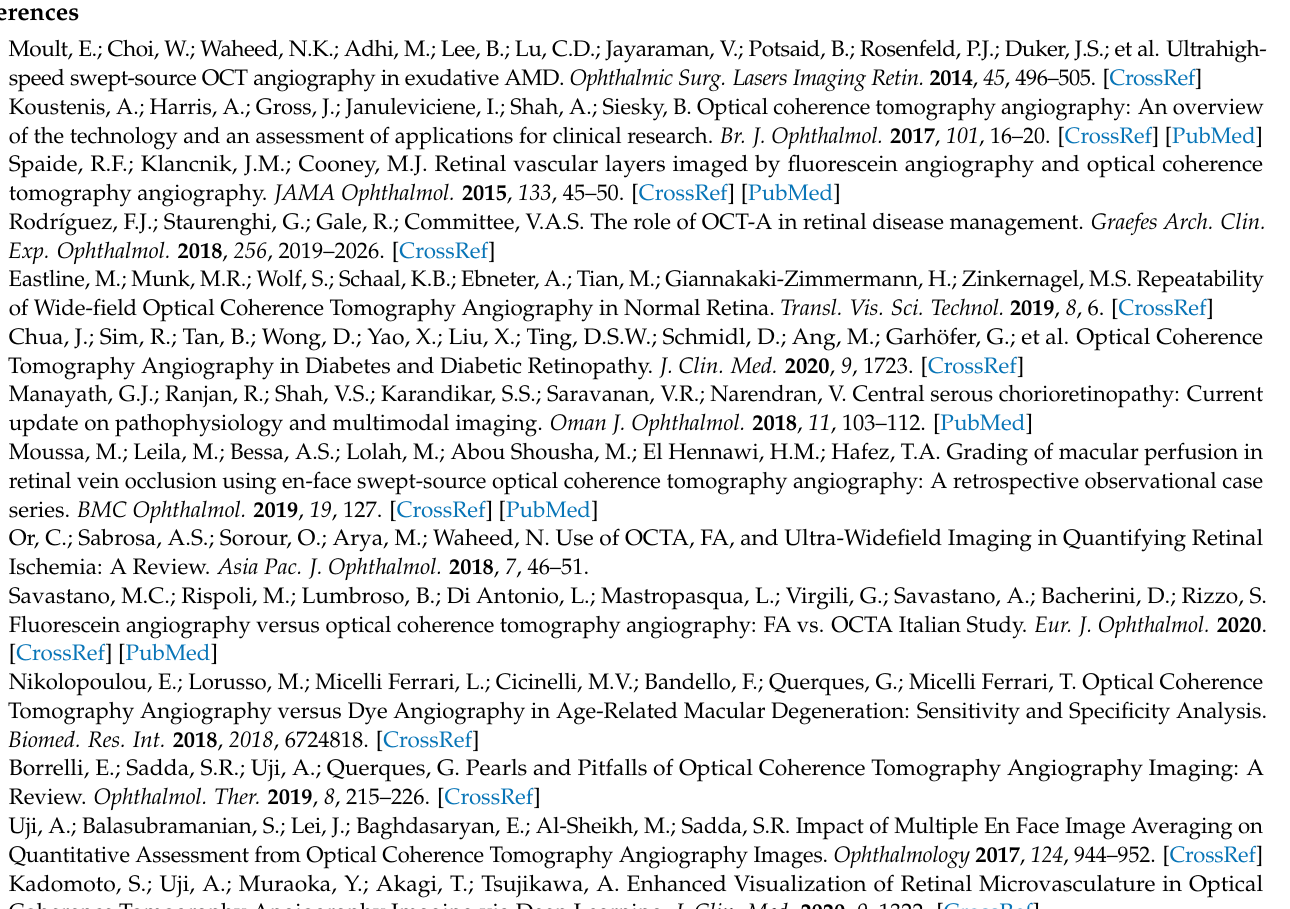
Figure A2. Proforma used by the retinal experts when comparing baseline to denoised OCT-A images.